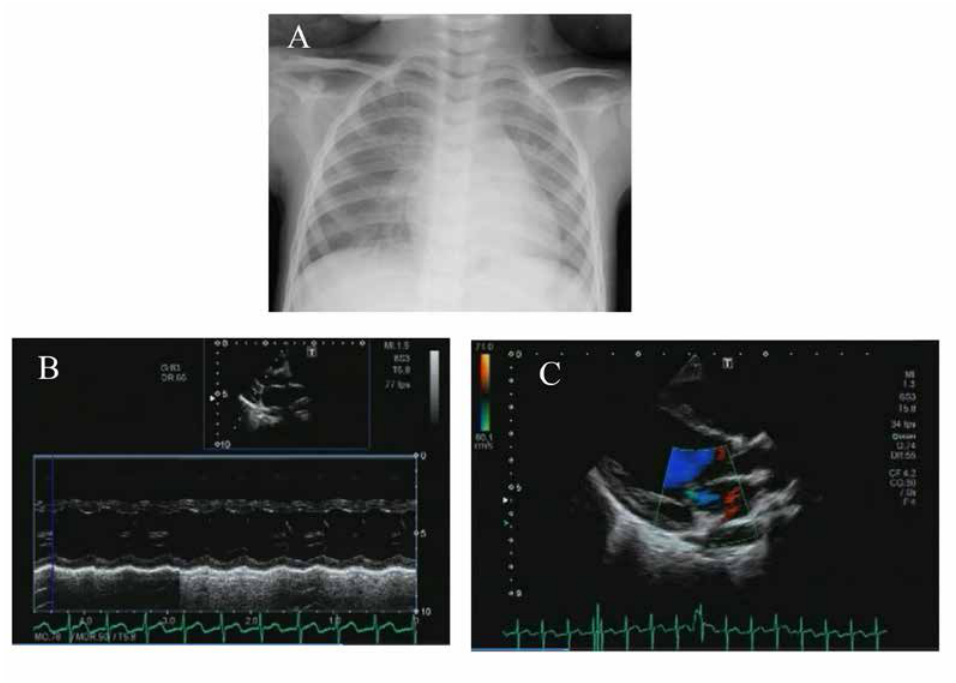
Figure 1: Image examinations on day 8 of illness A: Chest